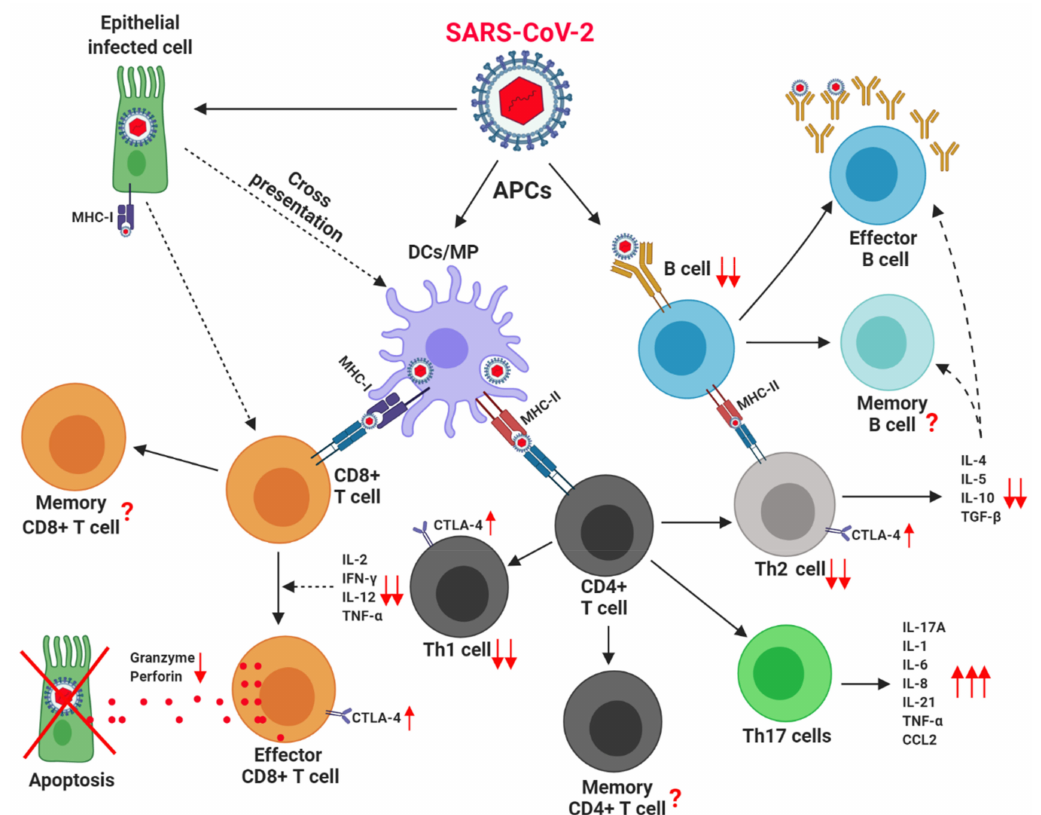
Figure 3. Adaptive Immune cells in obese/T2D patients, with critical COVID-19. Obese and T2D patients have pre-existing adaptive immune cell alterations. SARS-CoV-2 can infect antigen-presenting cells (APC) such as DCs, MP, and B cells, which present viral antigens to T cells via MHC I and MHC-II molecules. MHC-I molecules present cytoplasmic viral protein to CD8+ T cells; while MHC-II molecules present endoplasmic viral proteins to CD4+ T cells. Additionally, SARS-CoV-2 can directly infect other cells (e.g., epithelial cells), which could depend on cross-presentation of viral antigens by DC to activate virus-specific CD8+ T cells. Lymphocytopenia is a hallmark feature of severe COVID-19. The release of cytokines by CD4+ Th1 and Th2 cells appears to be decreased. In contrast, the expression of inhibitory molecule CTLA-4 appears to increase. The frequency and function of Th17 cells appears to predispose the development of ARDS. Despite the low number of B- lymphocytes IgG and IgA specific antibodies seems to be high. APC: Antigen presenting cells, IL: interleukins, TNF: Tumor necrosis factor, IFN: Interferon, DC: Dendritic cells, MP: Macrophages, MHC: Major histocompatibility complex, CTLA-4: Cytotoxic T-Lymphocyte Antigen 4, Th: T helper cells, CCL2: Chemokine (C-C motif) ligand 2. Created with